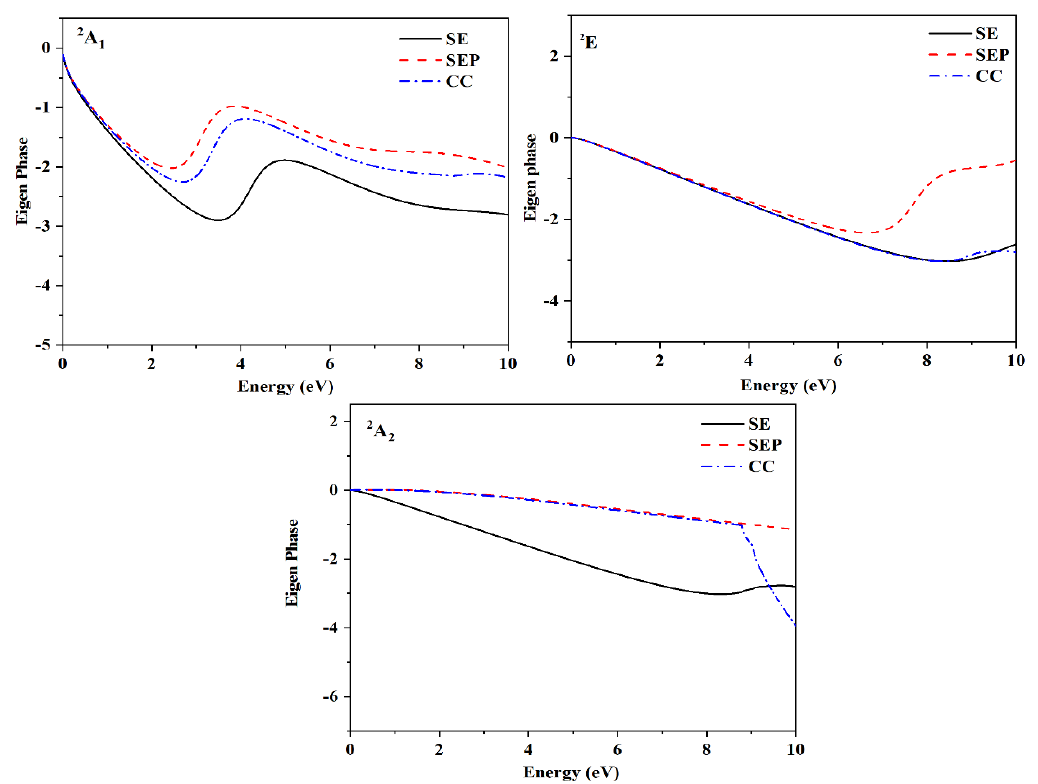
Figure 2. Eigen phase diagram for the doublet scattering states of e- c -C 4 F 8 scattering in C 2v sym- metry.